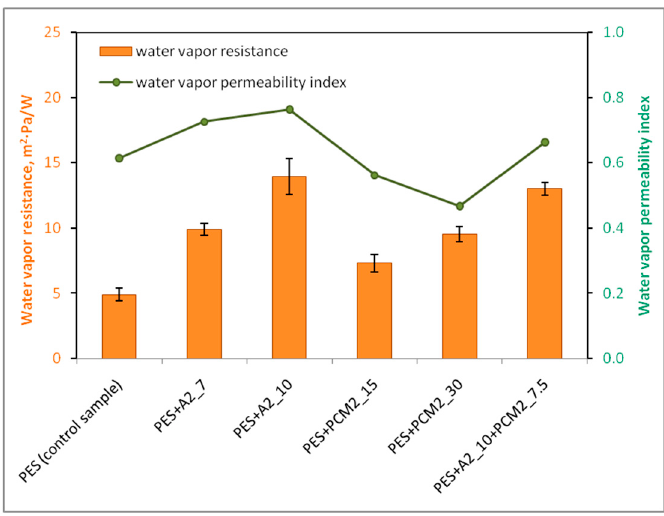
Figure 11. Water vapor resistance of the nonwoven inserts. Table 6. Comfort rating system based on evaporative resistance of fabrics. Adapted from [64,65].